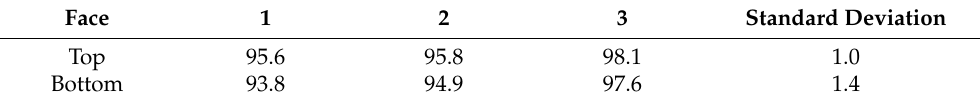
Table 5. Contact angle ( ◦ ) measured at three different positions of the membranes after extraction.